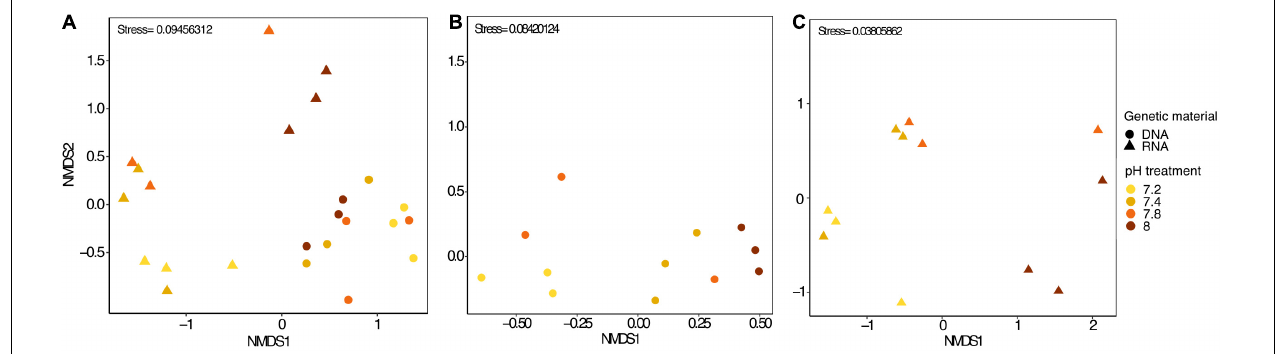
FIGURE 2 | (A) nMDS plot including all microbial samples (DNA and RNA), (B) only microbial DNA samples and (C) only microbial RNA samples from Stylophora pistillata kept in aquaria for 2 years at different pH treatments (pH 7.2, 7.4, 7.8 and 8.0). Data was transformed to Log (x + 1) and resemblance matrix based on Bray Curtis